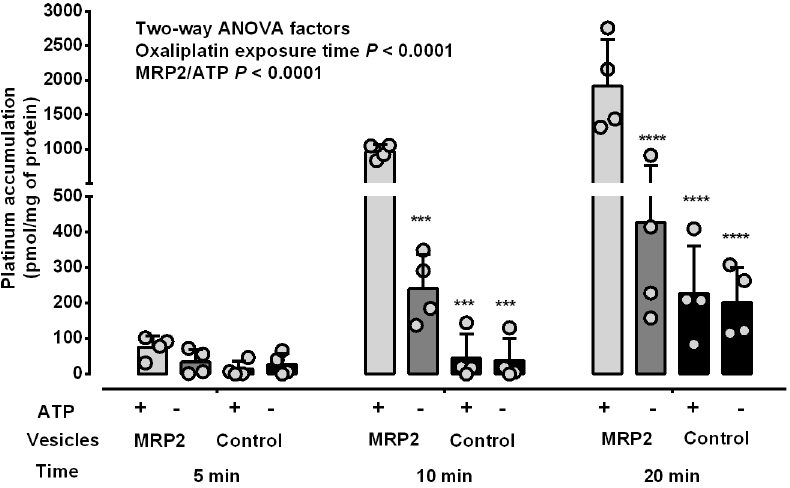
Fig 2. Membrane vesicle accumulation of oxaliplatin-derived platinum: dependence upon MRP2, ATP and oxaliplatin exposure time. MRP2-expressing and control membrane vesicles were incubated with oxaliplatin (100 μ M), with or without ATP (4 mM) for 5, 10 and 20 min, followed by measurement of platinum accumulation by ICPMS. The P values shown as numbers are from two-way ANOVA and those shown as *** ( P < 0.001) and **** ( P < 0.0001) are from Tukey ’ s multiple comparisons post-tests following two-way ANOVA for comparisons with MRP2-expressing membrane vesicles incubated with ATP at each respective time point. Bars represent means and standard deviations of individual values (open symbols) pooled from two independent experiments. Light grey bars, MRP2-expressing membrane vesicles with ATP. Dark grey bars, MRP2-expressing vesicles without ATP. Black bars, control membrane vesicles.